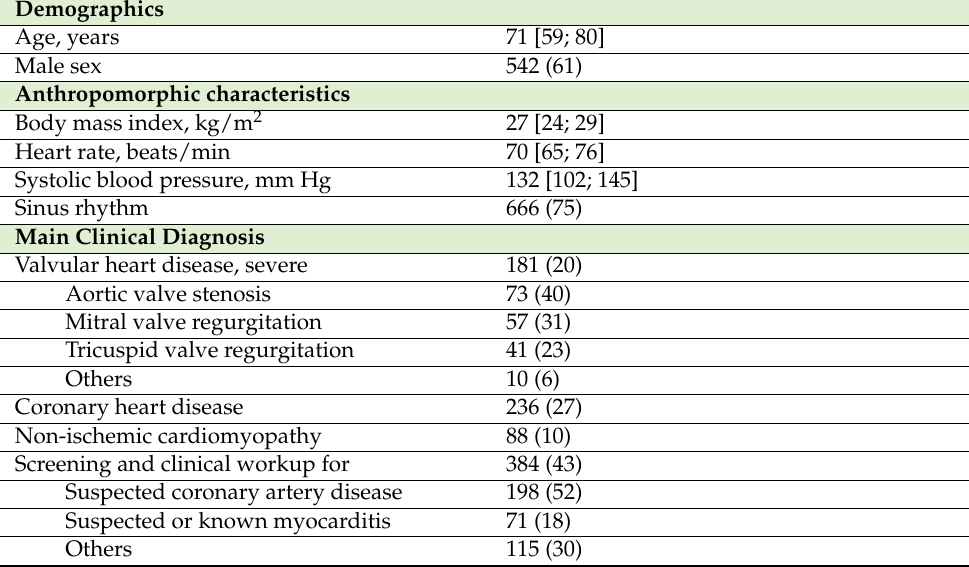
Table 1. Characteristics of the Studied Population ( N =